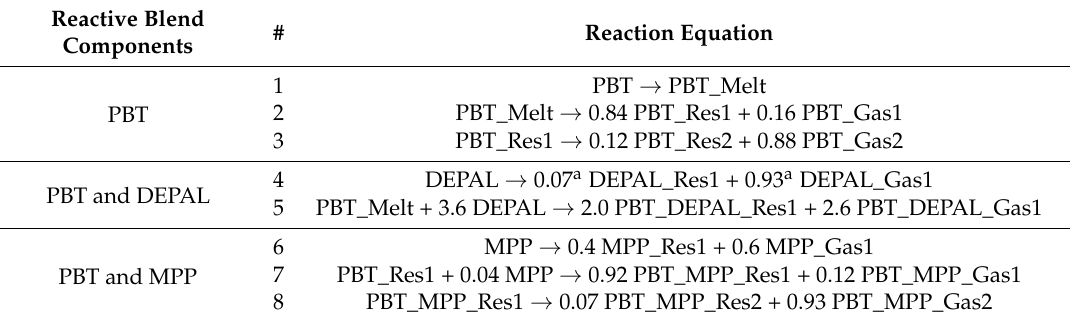
Table 2. Reaction mechanism for all the materials examined in this study. The stoichiometric coefficients are mass-based.